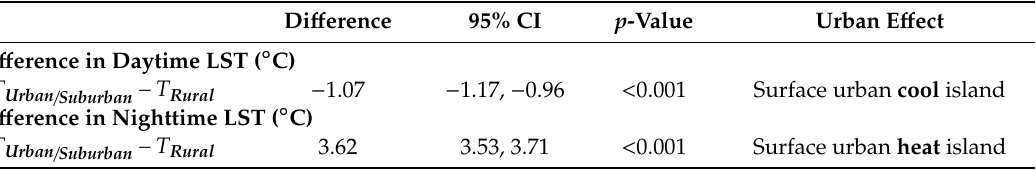
Table 3. Urban heat and cool e ff ects of urban / suburban and rural governorates in